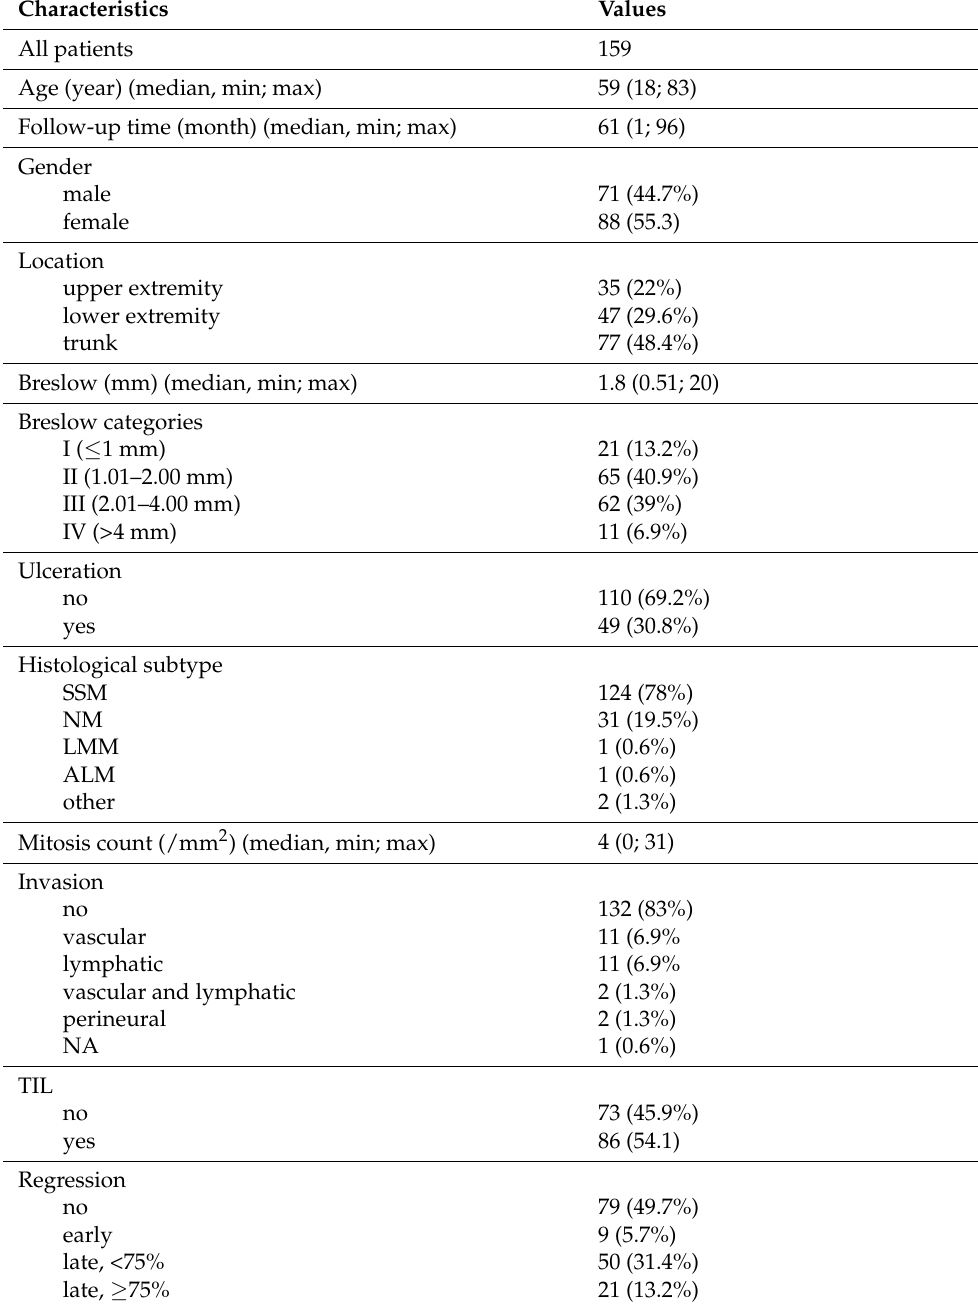
Table 1. General characteristics of the studied patients with